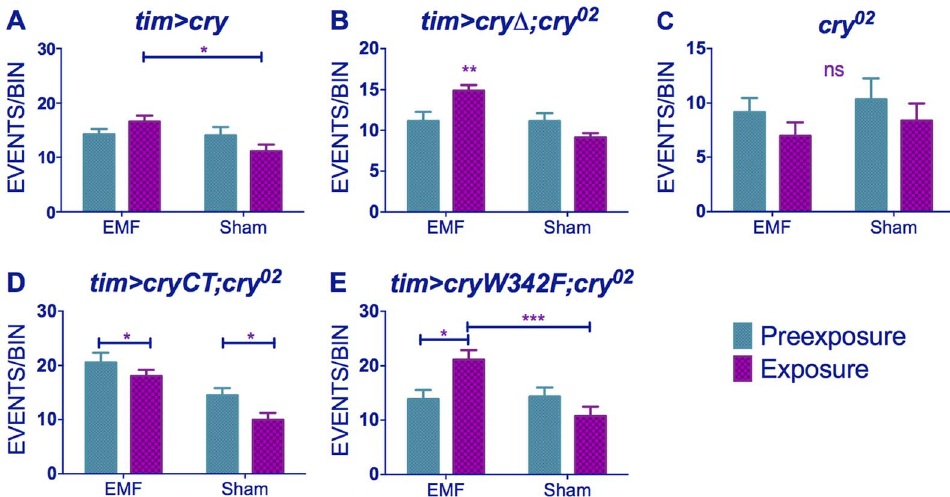
Figure 5. EMF-induced hyperactivity in cry variants. (A) tim . cry (B) tim . cry D ;cry 02 (C) cry 02 (D) tim . cryCT;cry 02 (E) tim . cryW342 F;cry 02 N’s are the same as in Figure 3. Mean 6 sem. (see Table S2, post-hoc *p , 0.05, **p , 0.01, ***p , 0.001).